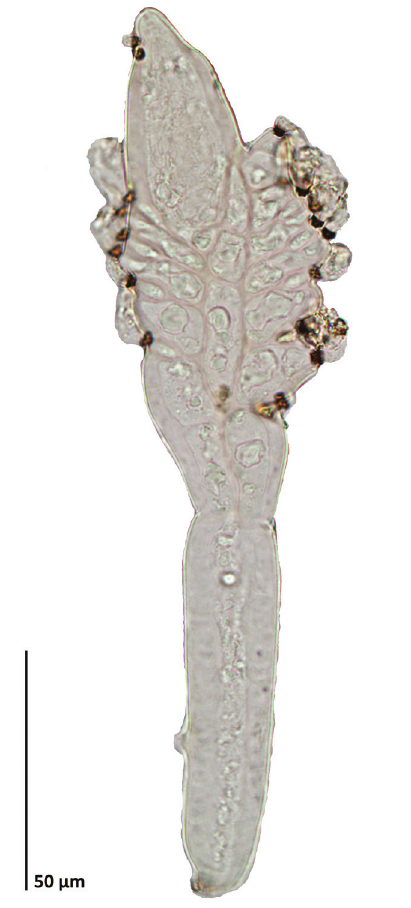
Figure 2. Photograph of a slide-mounted Rickia wasmannii thallus (deposition number: G00562301) from Myrmica hellenica host, recorded on the AntWeb (specimen: